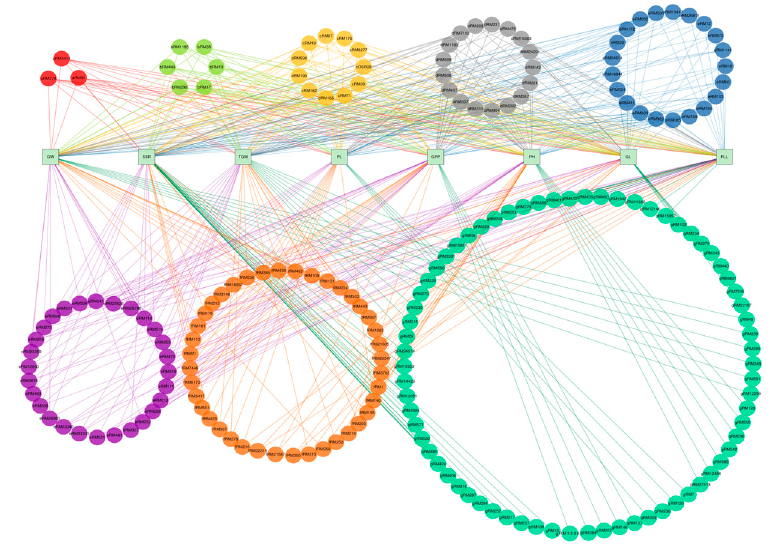
Figure 3. Network diagram of the relationship between eight agronomic traits and gradient molec-